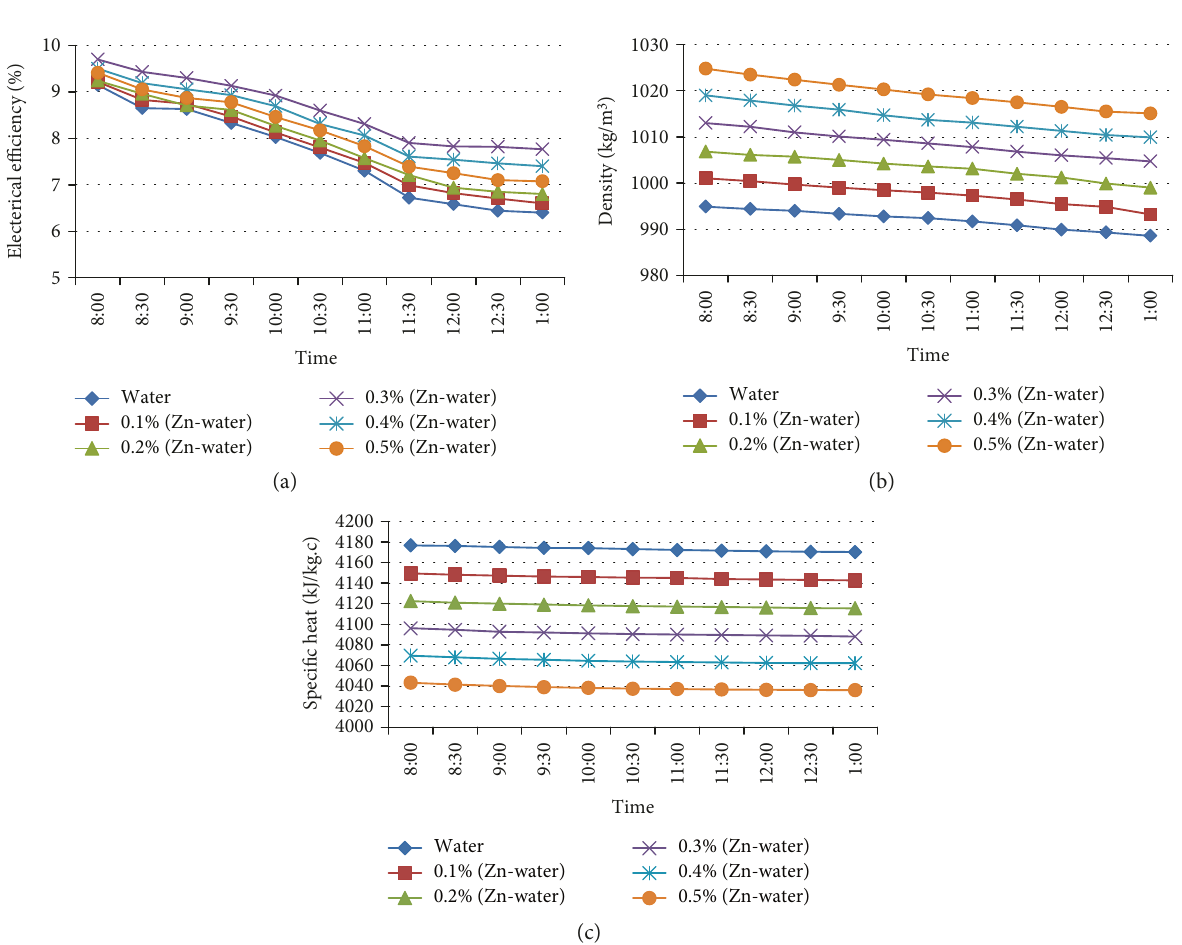
Figure 10: E ff ect of Zn-H O nano fl uid concentrations at 2L/min on (a) electrical e ffi ciency, (b) working fl uid density, and (c) speci fi c 2